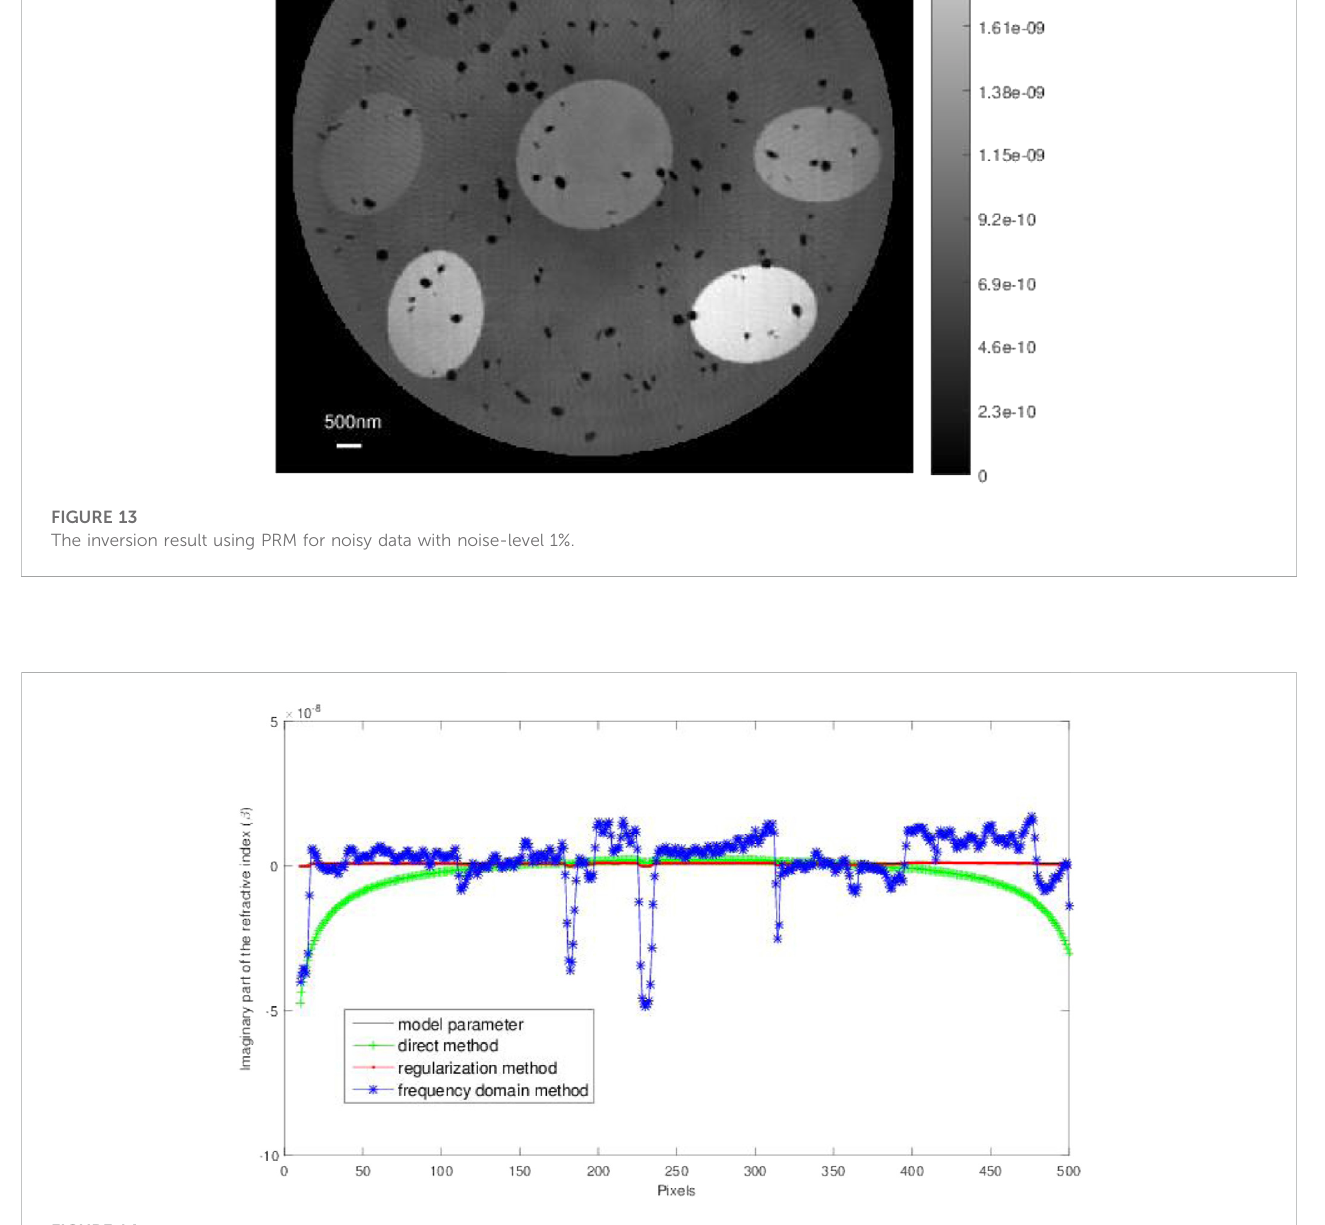
FIGURE 14 Comparison of three methods on their pro fi les for noisy data with noise-level